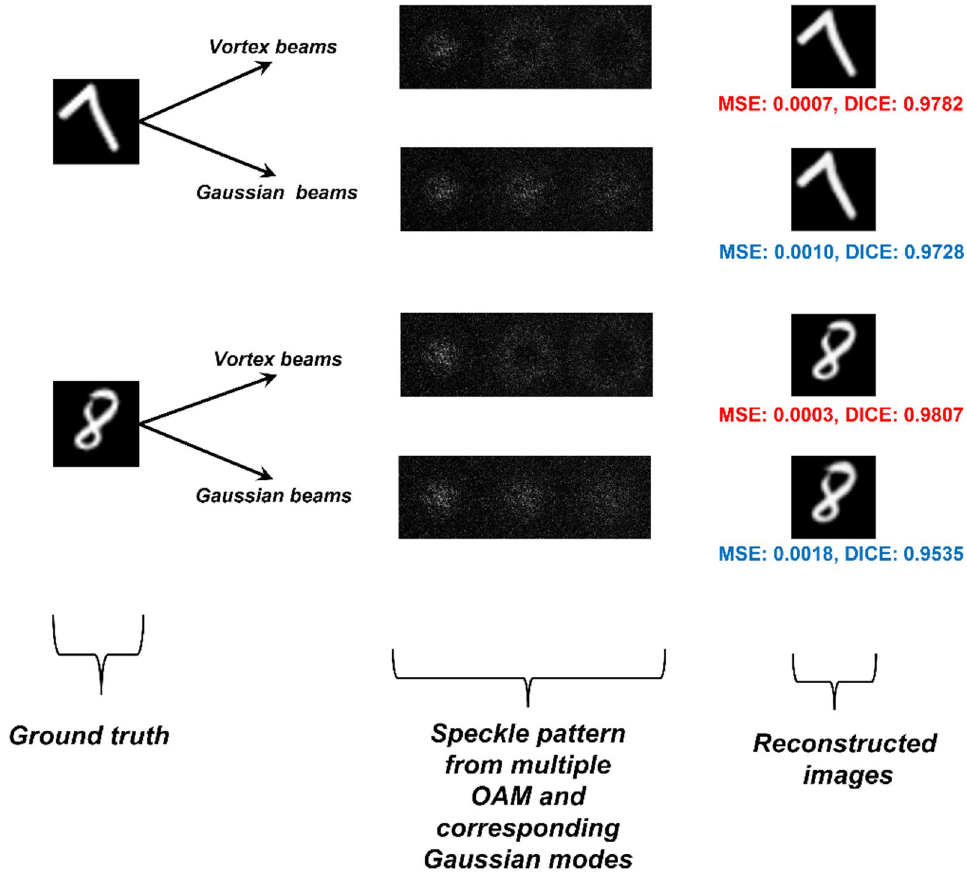
Figure 5. The patterns from the vortex beams and the Gaussian beams and the reconstructed images using the CNN are